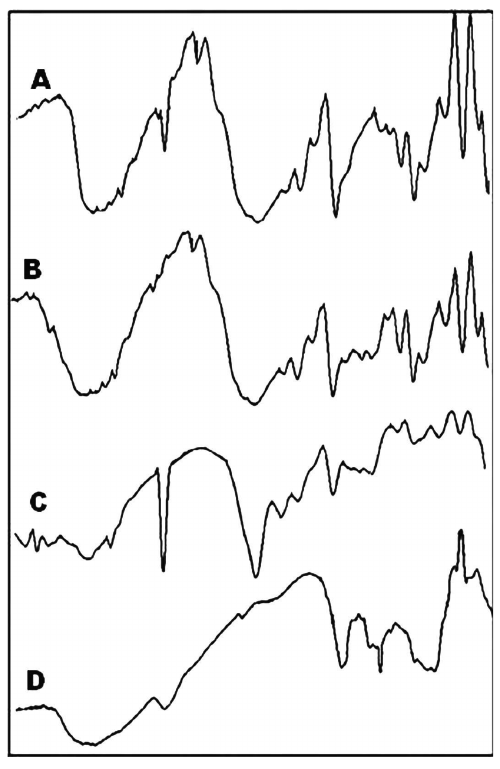
FIGURE 5 - FTIR spectra of 5-fluorouracil (A), formulation CLH63 before storage (B), formulation CLH63 after storage (C) and placebo formulation of CLH63